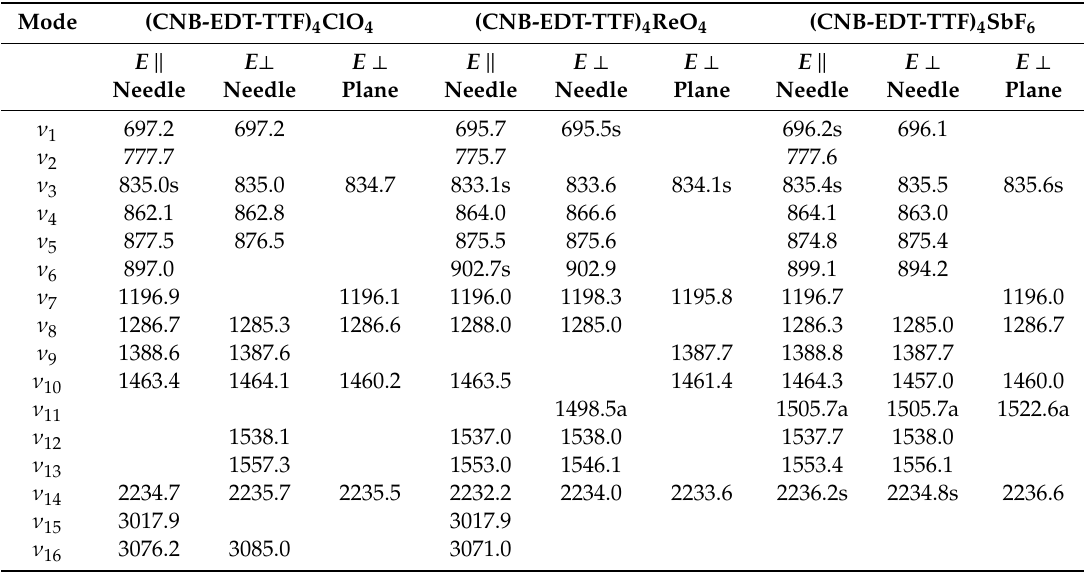
Table 2. Vibrational modes frequencies (cm − 1 ) of (CNB-EDT-TTF) 4 ClO 4 , (CNB-EDT-TTF) 4 ReO 4 , and